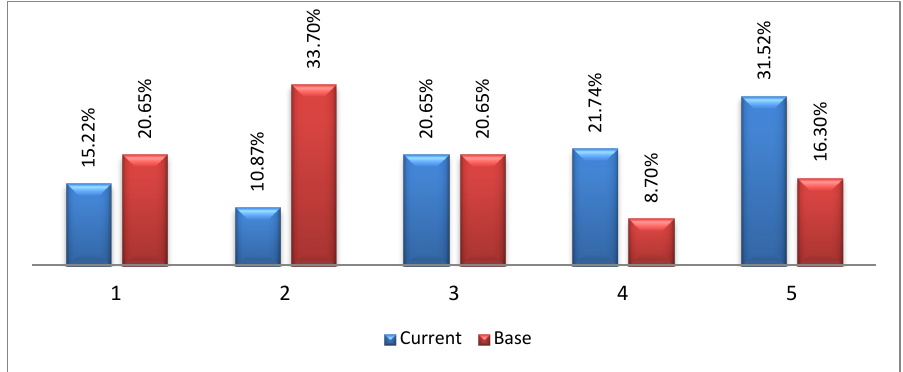
FIGURE 5(a): Tone on integrated reporting components in introduction, chairman's and CEO's commentary